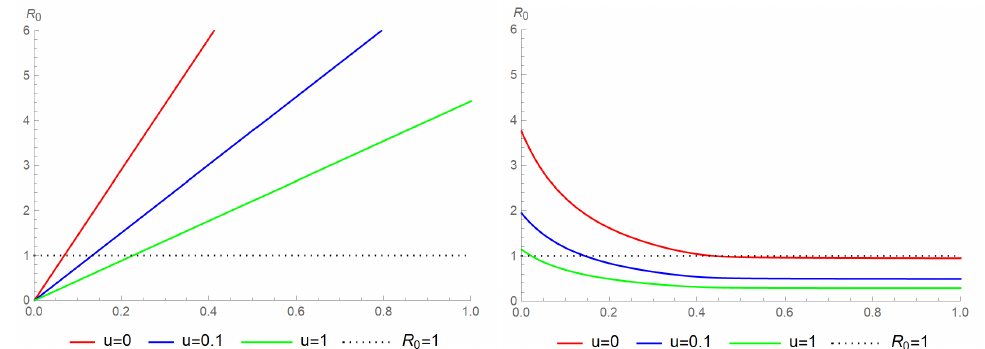
Figure 2. The diagram on the left illustrates how the reproduction number depends on the infection rate, β i = β , for different constant controls, u i ( t ) = u ( 0 ) = u . Meanwhile, the diagram on the right demonstrates how the reproduction number varies with the migration rate, m 21 = m , for different constant controls, u m 32 S